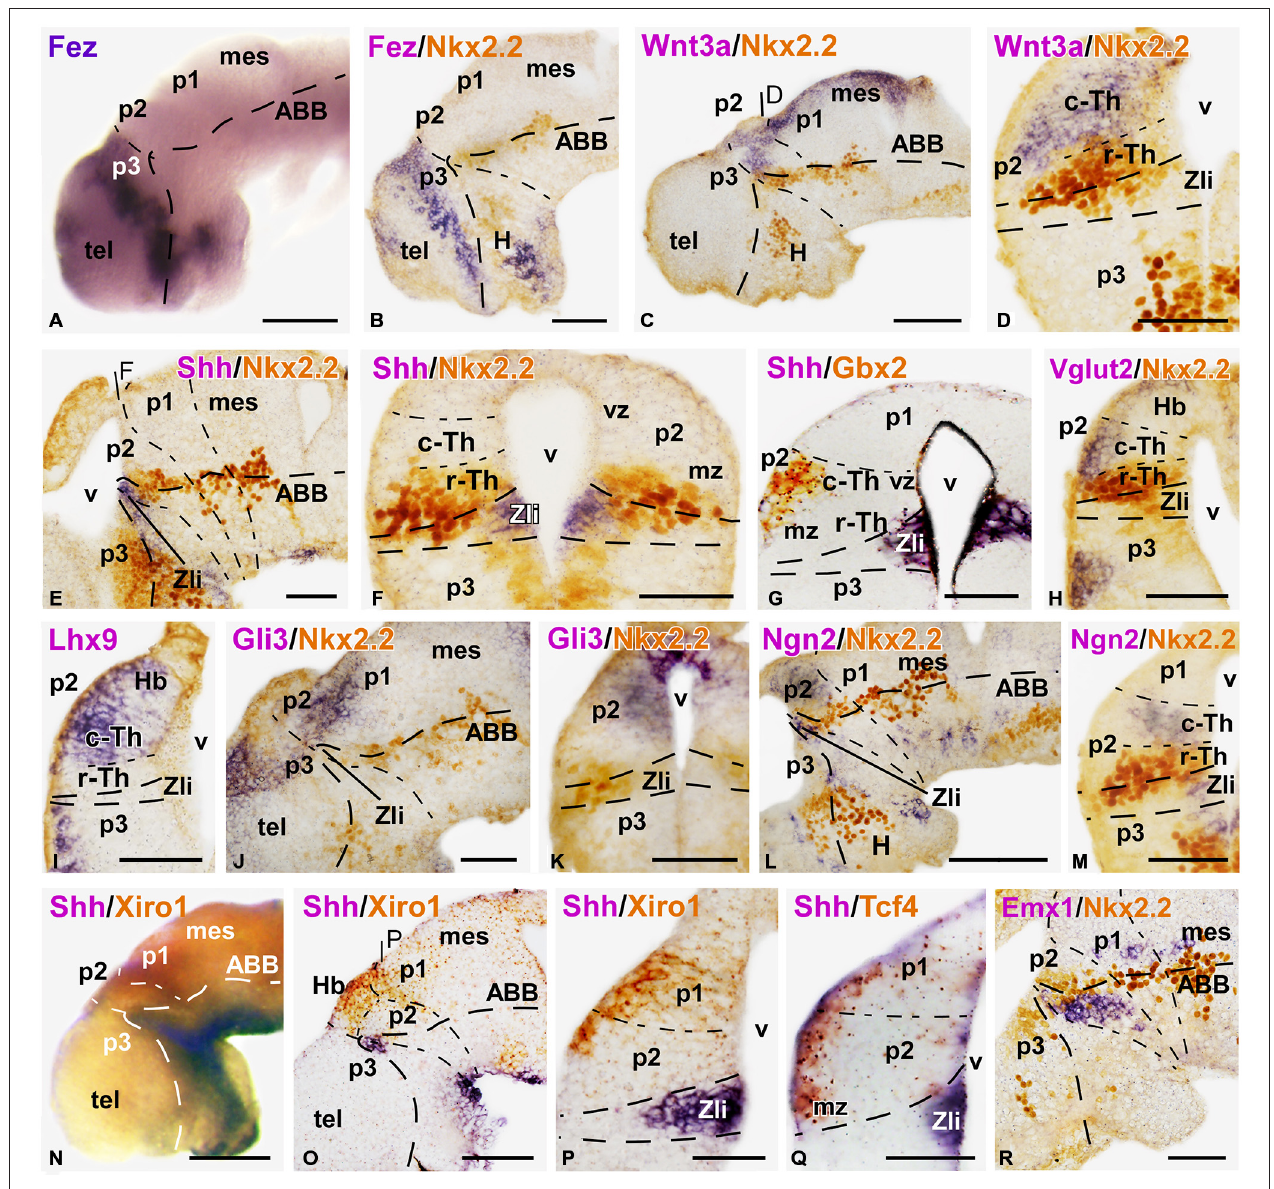
same standard: dorsal is upwards in transverse and sagittal sections, and rostral is to the left in sagittal sections. The neuromeric boundaries and main brain subdivisions are indicated to assist in the precise localization of the labeling. At these stage c-Th and r-Th subdivision of the thalamus were distinguished (M) . The levels of the transverse sections (D,F,P) are indicated in photographs (C,E,O) , respectively. Scale bars = 100 µ